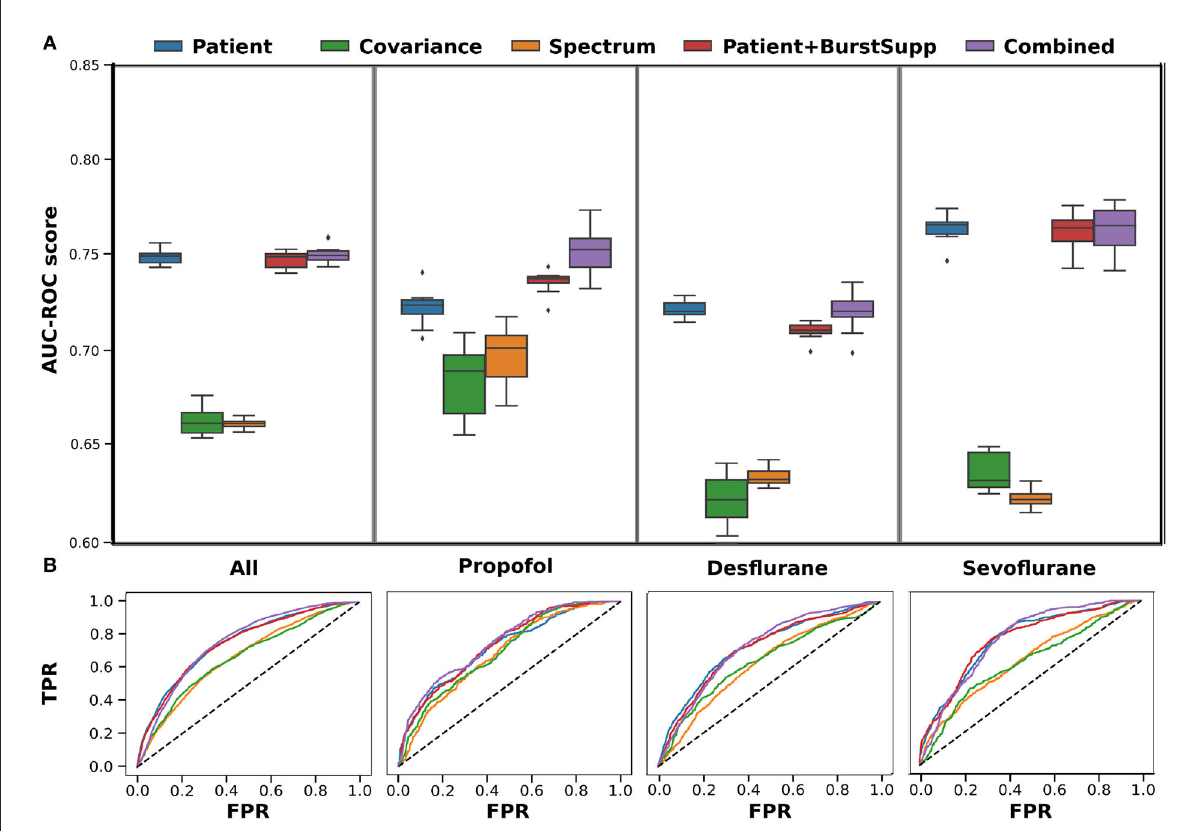
FIGURE4 Cross-validation-results for training on all medications. Results shown for each medication group, left all, 2. Propofol, 3. Desflurane and right Sevoflurane, for each of the classifiers patient (features: anesthetic agent, benzodiazepine, ASA, Age, OP length) (blue), covariance (green), spectrum (orange), patient+burstsupp (patient and burst suppression features) (red), combined risk evaluation (violet). (A) ROC-AUC values in box plot over 10 repeats of 10-fold cross-validation. (B) Mean ROC-curves for 10 repeats of a 10-fold